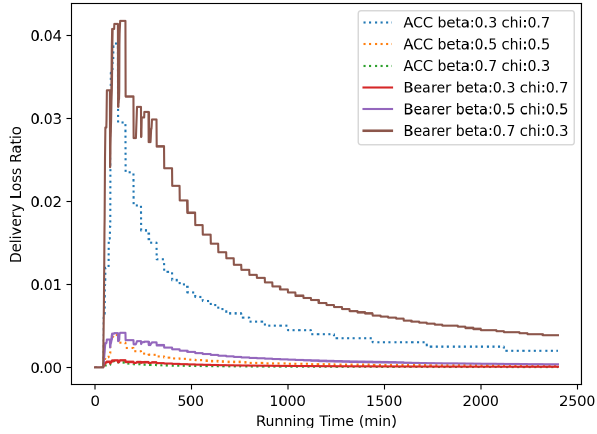
Figure 9. Traffic adjustment factor optimizing curve.